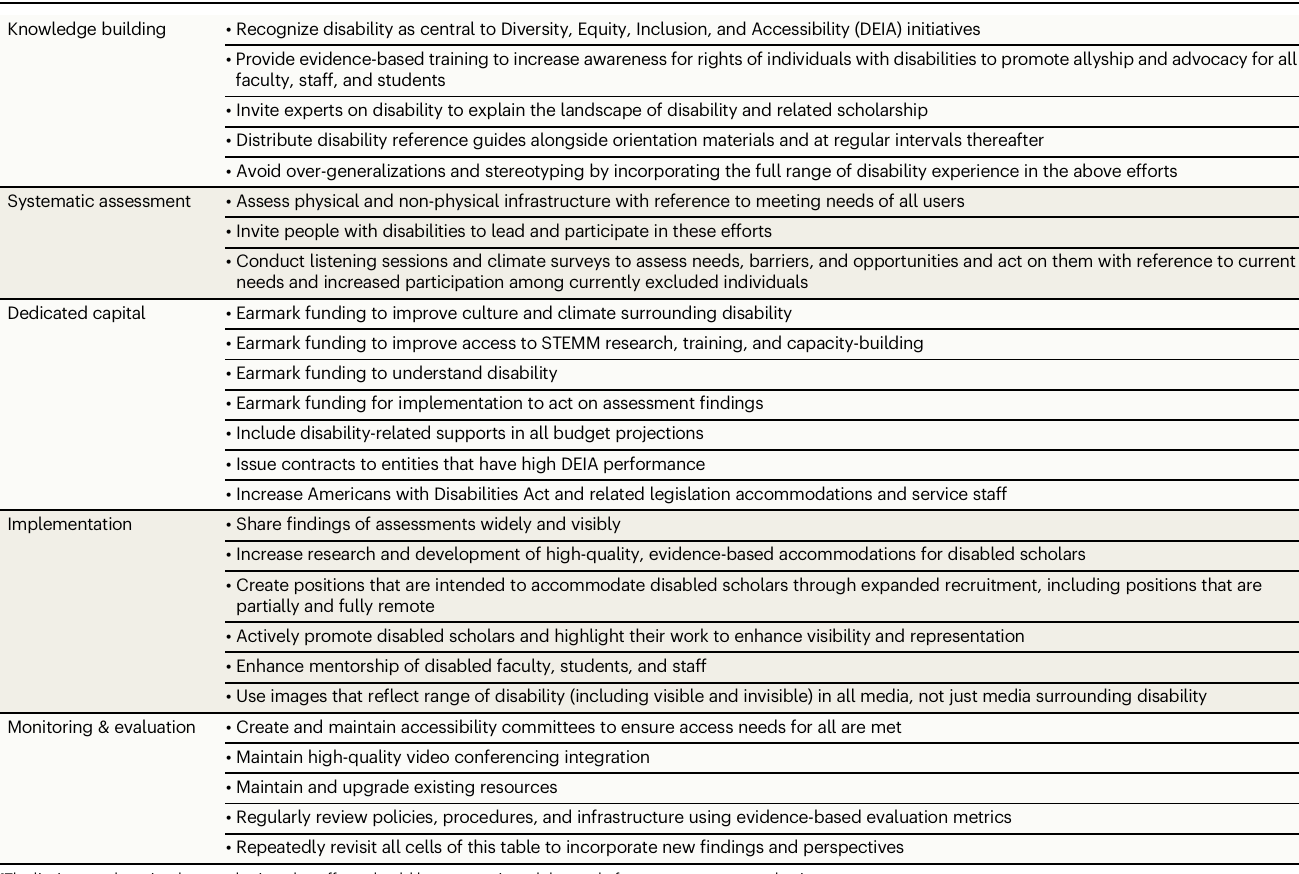
Table 1 | Suggestions for systematic application of FAM principles to improve participation of disabled people in STEMM